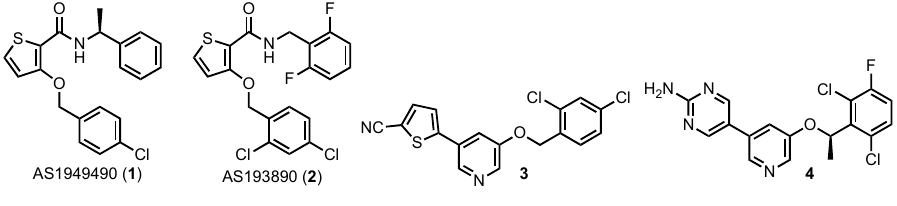
Figure 6. SHIP2 Inhibitors.